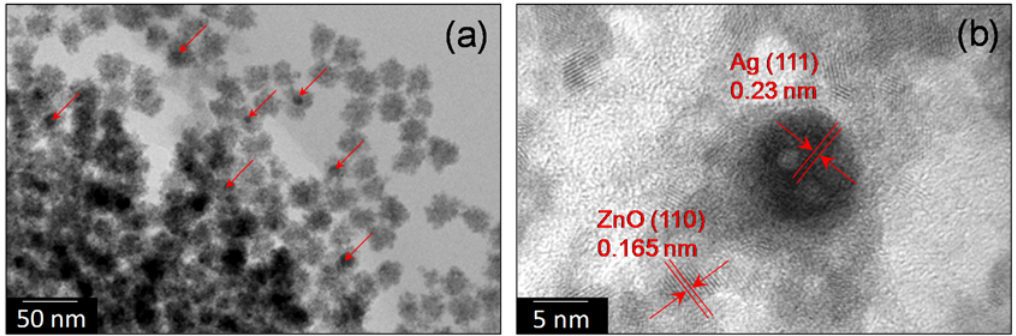
Figure 2. TEM ( a ) and HRTEM ( b ) images of Ag@ZnO core-shell nanoparticles synthesized by the sonochemical technique and dried at 80 °C for 2 h.